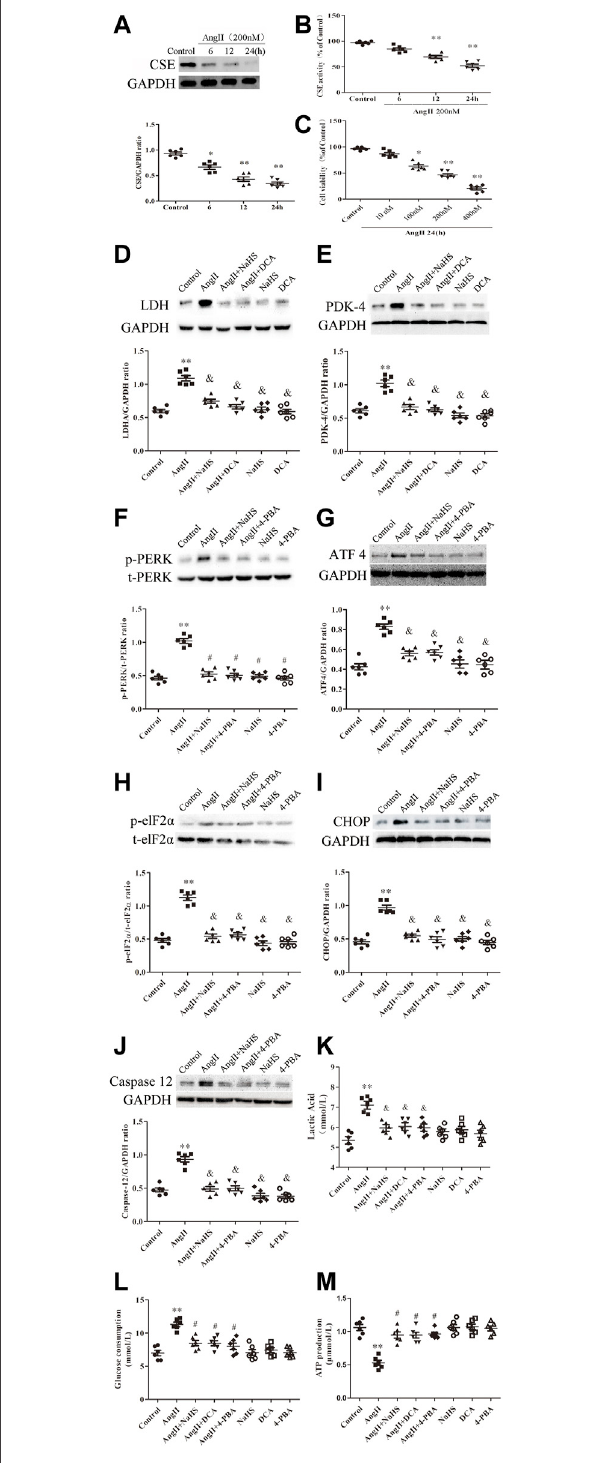
FIGURE 5 | each group). (B) Detection of CSE activity by methylene blue assayintheHL-1celloftheindicatedgroups( n (cid:1) 6ineachgroup).CCK-8was used to detect the changes in HL-1 cell viability induced by Ang II at different times (C) ( n (cid:1) 6 in each group). Representative Western blotting and relative densitometry analysis of (F) p-PERK with t-PERK as the loading control and (H) p-elF2 α with t-elF2 α as the loading control and (D) LDH, (E) PDK-4, (G) ATF 4, (I) CHOP and (J) caspase12 with GAPDH as the loading control in the HL-1 cell of the indicated groups ( n (cid:1) 6 in each group). Lactate acid (K) and glucose consumption (L) and the production of ATP (M) were determined by kit analysis in the HL-1 cell of the indicated groups ( n (cid:1) 6 in each group). **p